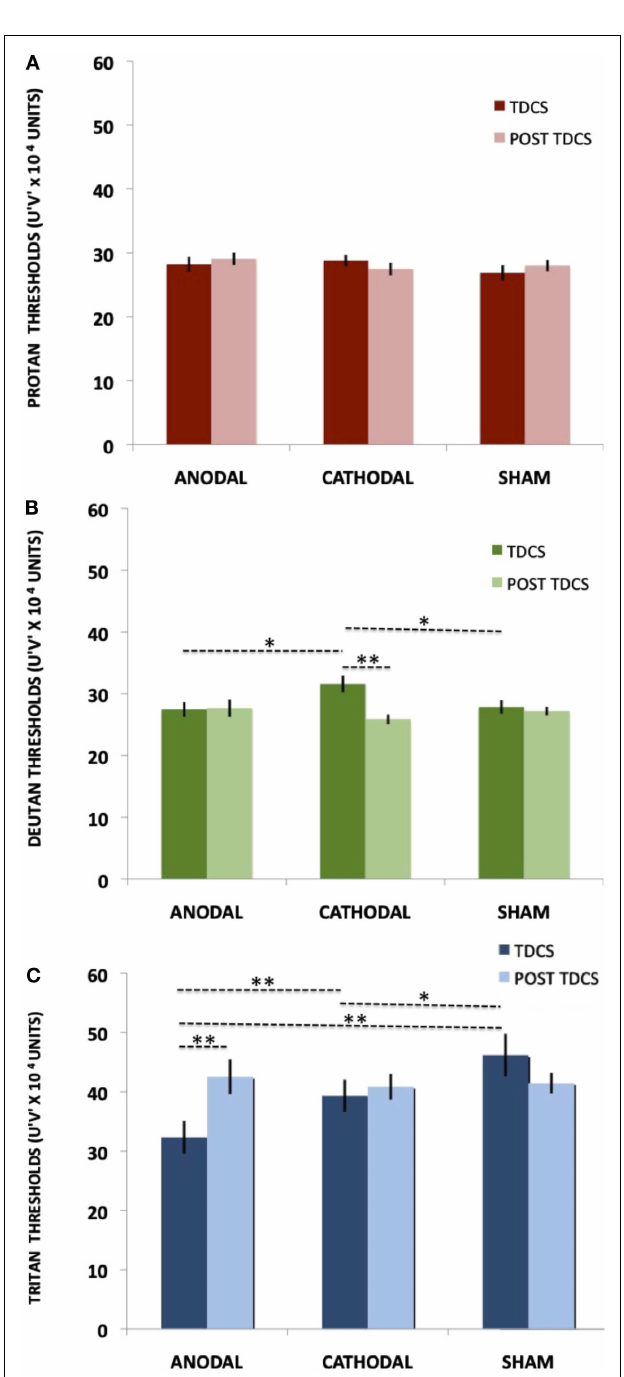
FIGURE 4 | Online tDCS and Post tDCS comparisons. The bars represent the means and the vertical lines represent SE. Statistically significant comparisons are marked with asterisks ( * p < 0.05 and ** p < 0.01). (A) Protan threshold values for both tDCS and post tDCS conditions. (B) Deutan threshold values for both tDCS and post tDCS conditions. (C) Tritan threshold values for both tDCS and post tDCS conditions.